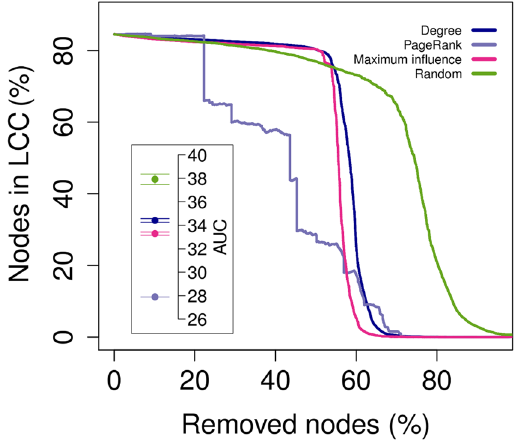
Figure 3. Effort needed to immunize the olive orchard network. Lines show the fraction of nodes remaining in the largest connected component (LCC) of the olive orchard network after progressive node removal according to different criteria (see Methods). The solid lines interpolate the average values of 100 replicates. The inner box reports the average areas under the curve (over 100 replicates) for each removal criterion, rescaled between 0 and 100, with error bars indicating standard